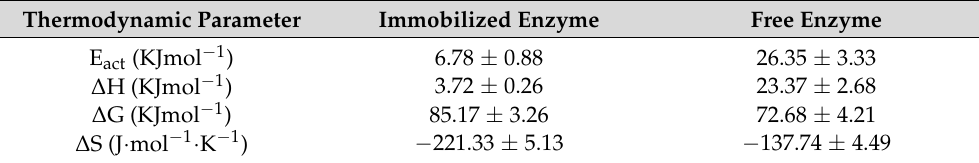
Table 1. Thermodynamic parameters of immobilized and free enzyme for LBG